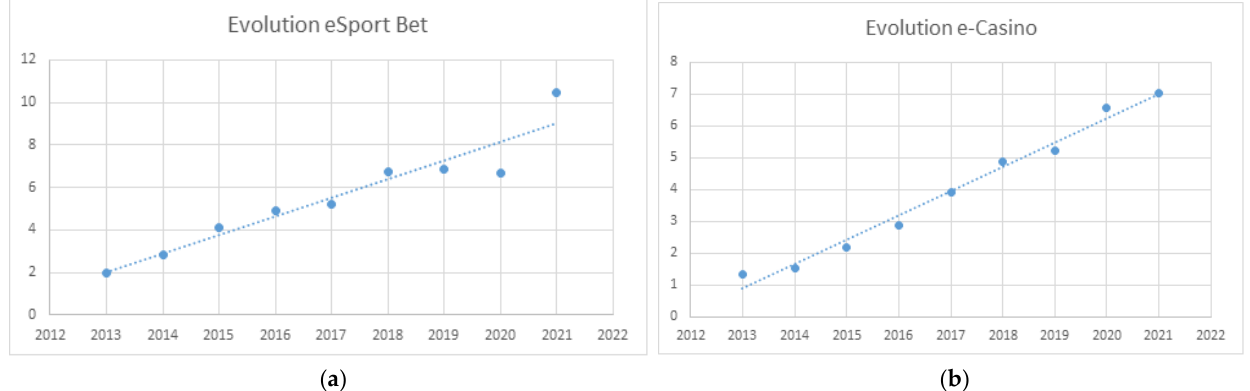
Figure 4. ( a ) Evolution of online sports betting spending; ( b ) Evolution of online casino game (e-roulette and e-Blackjack) spending.